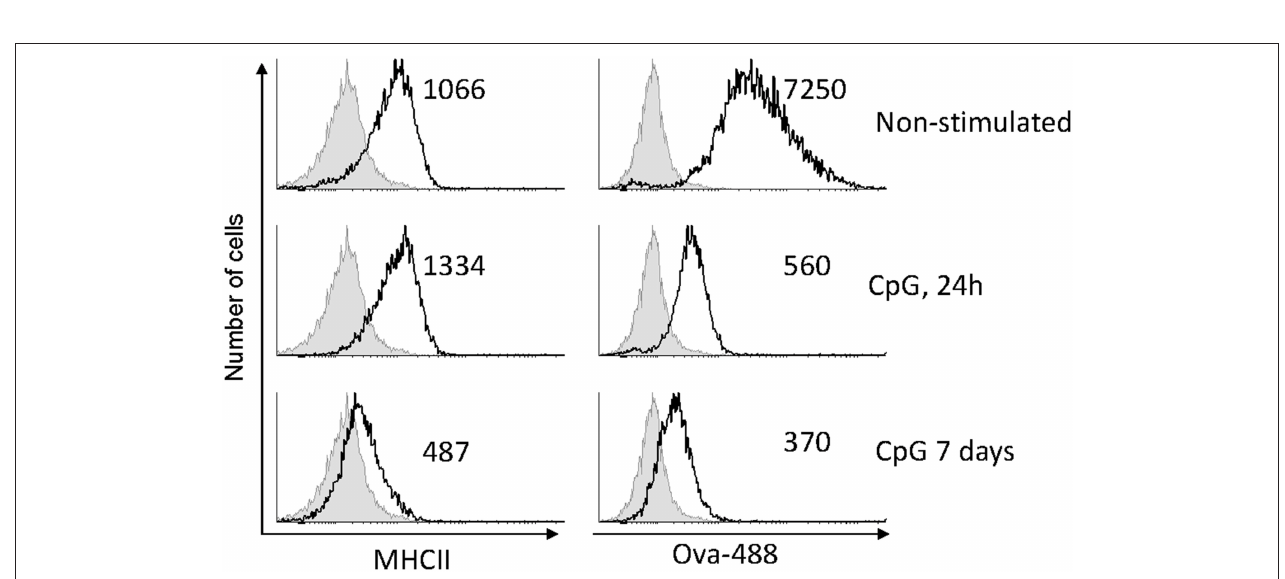
FIGURE 3 | CpG stimulation reduces antigen uptake capacity of MPs and, after a prolonged treatment, downregulates surface MHCII expression. MPs were either left untreated or stimulated with 2 µ M CpGs for 1 and 7 days, as indicated. The cells were incubated with 10 µ g/ml of Ova conjugated with AlexaFluor-488 for 1h prior to harvesting and analysis using flow cytometry. The numbers in the individual histograms show the mean fluorescence intensities of the stained samples (black contours). The non-stained samples are represented with filled gray contours. Representative results from two experiments with cells from different individuals are shown.